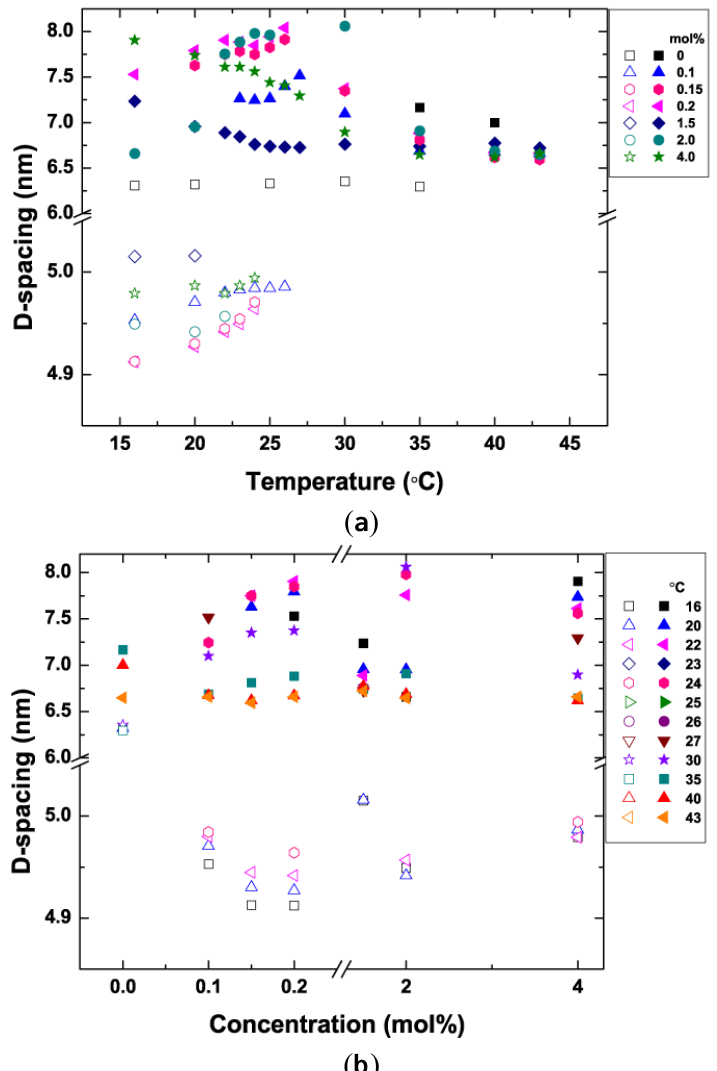
Figure 5. Lamellar d-spacing in the L β′ (open symbols) and L α (solid symbols) phases as a function of: ( a ) temperature (for different DHA concentrations); and ( b ) DHA concentration (at different temperatures). Where the two phases coexist both open and solid symbols are present at the same temperature (plot a) or concentration (plot